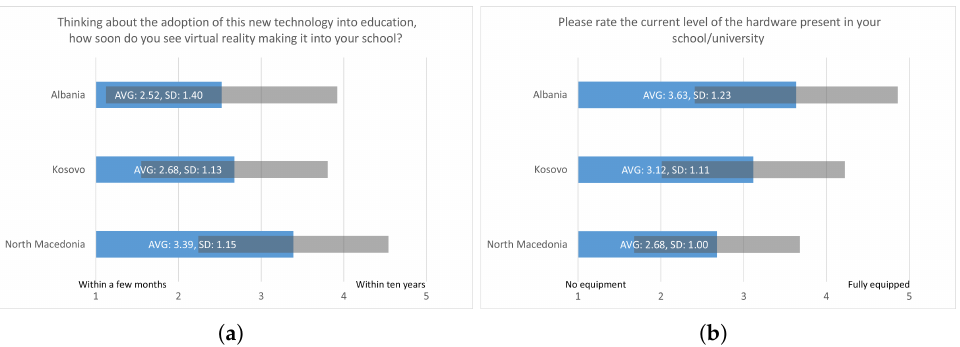
Figure 8. ( a ) Future timeline of adopting new technologies in teaching. ( b ) Possession of hardware at the